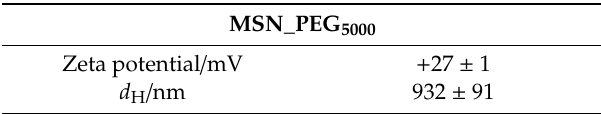
Table 2. The zeta potential of MSNs and the average diameter size of aggregates formed by dispersing of MSNs in